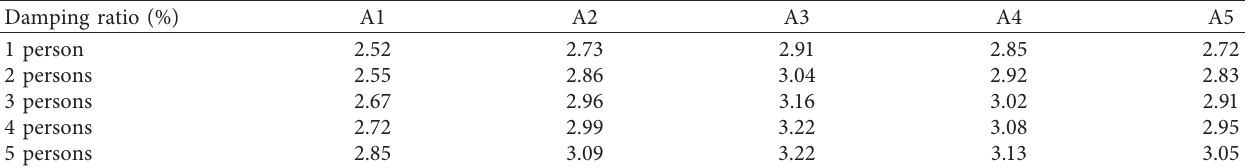
Table 3: Damping ratio (%) owing to multiperson heel-drop